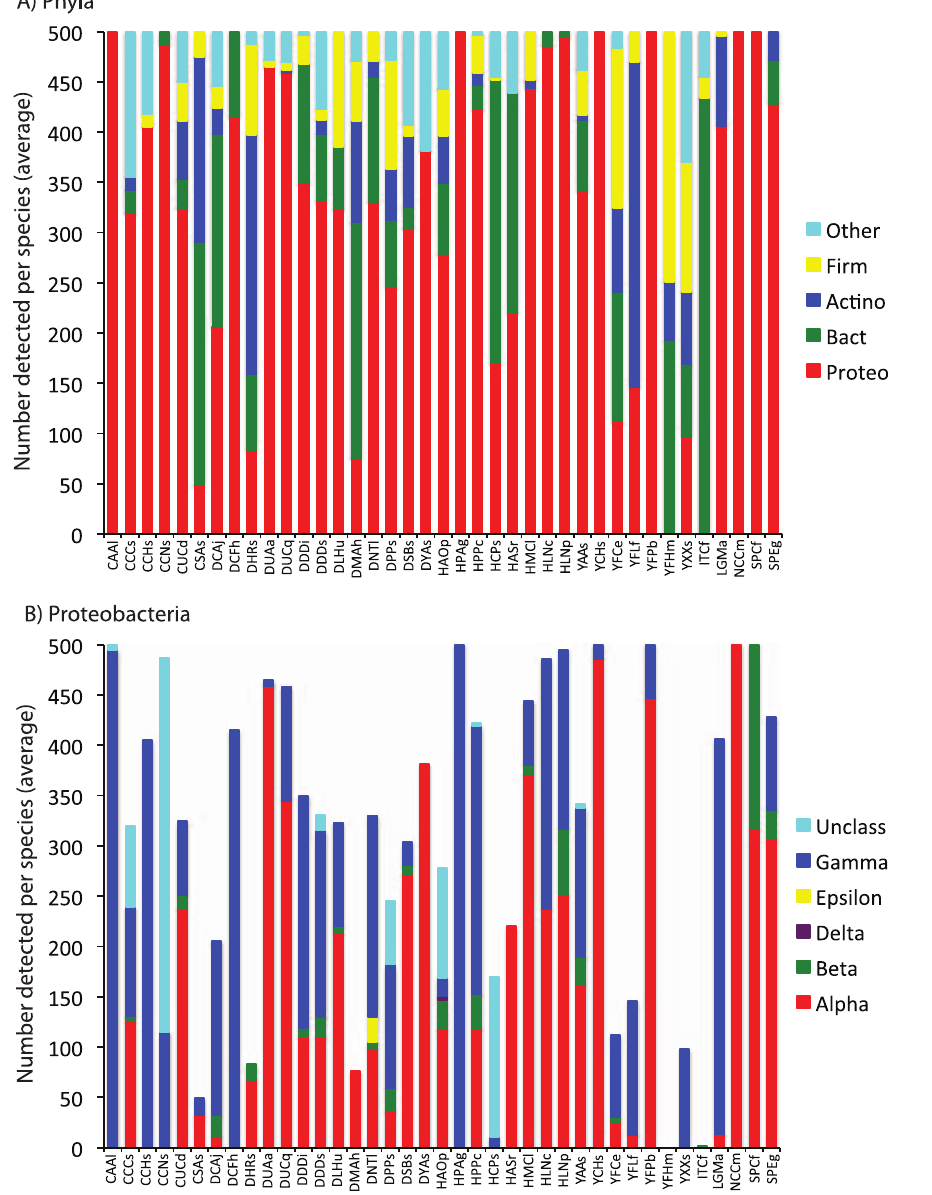
Figure 1. Classification of bacterial community members for each insect species. Values are averaged across all samples within the species. Bacteria are classified to phylum (Firm=Firmicutes; Actino=Actinobacteria; Bact=Bacteroidetes; Proteo=Proteobacteria) (A). Proteobacteria are classified to sub-phylum (B). Each column is an insect species, which are subsequently grouped according to insect family and insect order. Four letter codes for insect species are detailed in Table